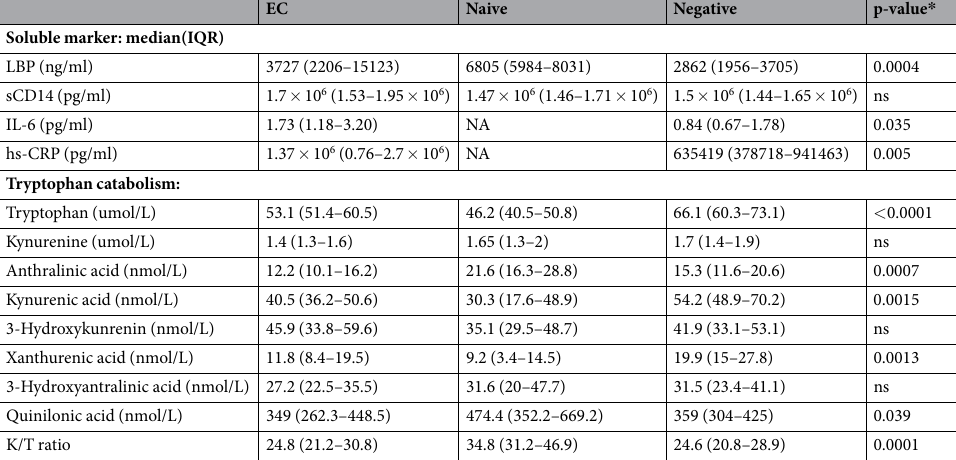
Table 2. Soluble markers of inflammation and metabolites of kynurenine/tryptophan catabolism in plasma. * Kruskal-Wallis test was used for comparison between three groups, and Dunn’s Multiple Comparison Test for post-hoc pairwise analyses. Two-tailed Mann-Whitney U-test was applied for comparisons between two groups. NA (not available). ns (non significant) indicates p-value > 0.05.